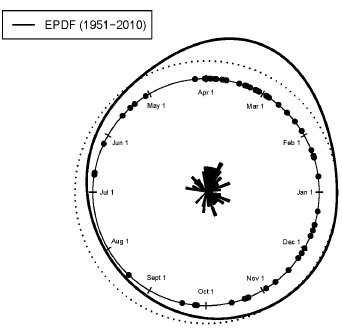
Figure 1. Empirical probability density function (EPDF) estimates of the annual maximum streamflow dates for Blockhouse Creek near the English Center in Pennsylvania. The dotted line represents the median estimate for significance based on density estimates using resampled data ( n = 1000).